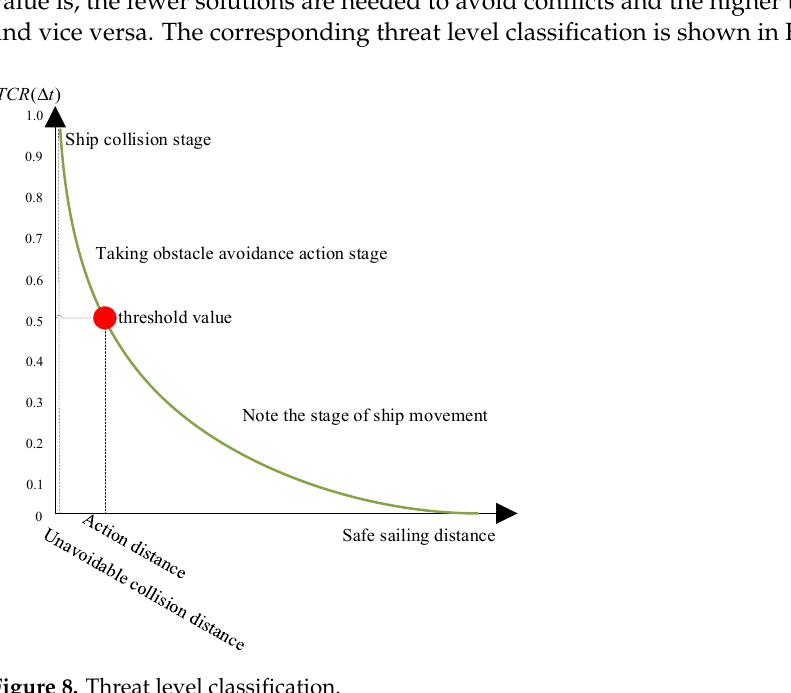
Figure 8. Threat level classification.